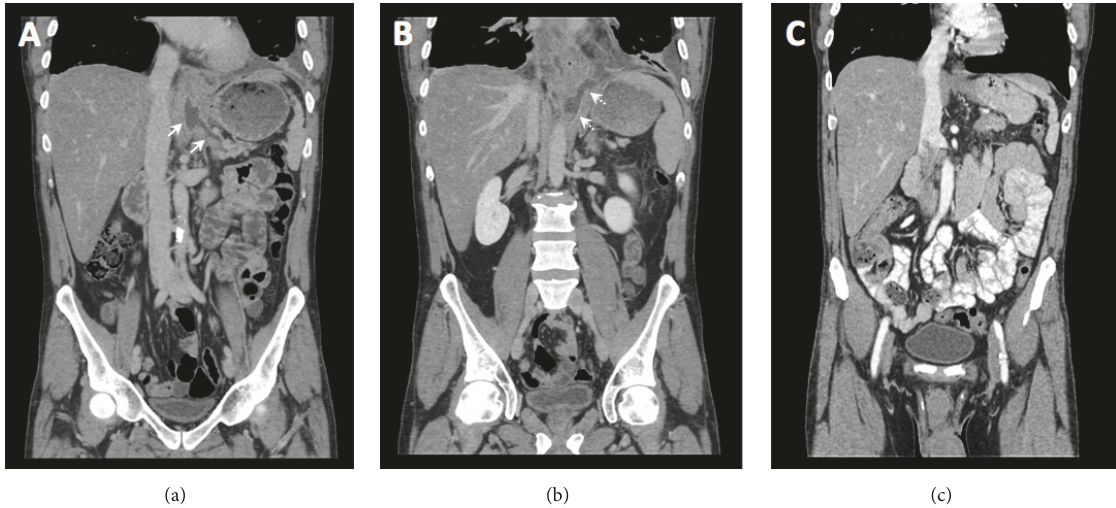
Figure 2: Coronal views of contrast-enhanced CT of the abdomen and pelvis show a fistula tract arising from the tail of the pancreas ((a) white arrows) extending caudally and connecting to the left pleural space ((b) dashed white arrows) with small pleural effusion and overlying atelectasis. A follow-up CT (c) demonstrates resolution of the fistula tract and pleural